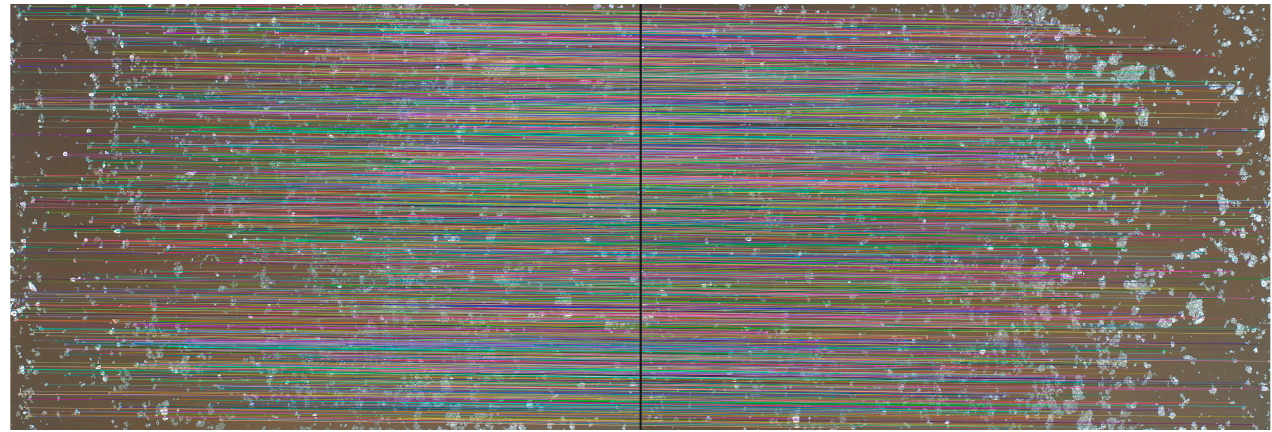
Figure 4. Distribution of feature point pairs at 8:00 on 26 April 2021.